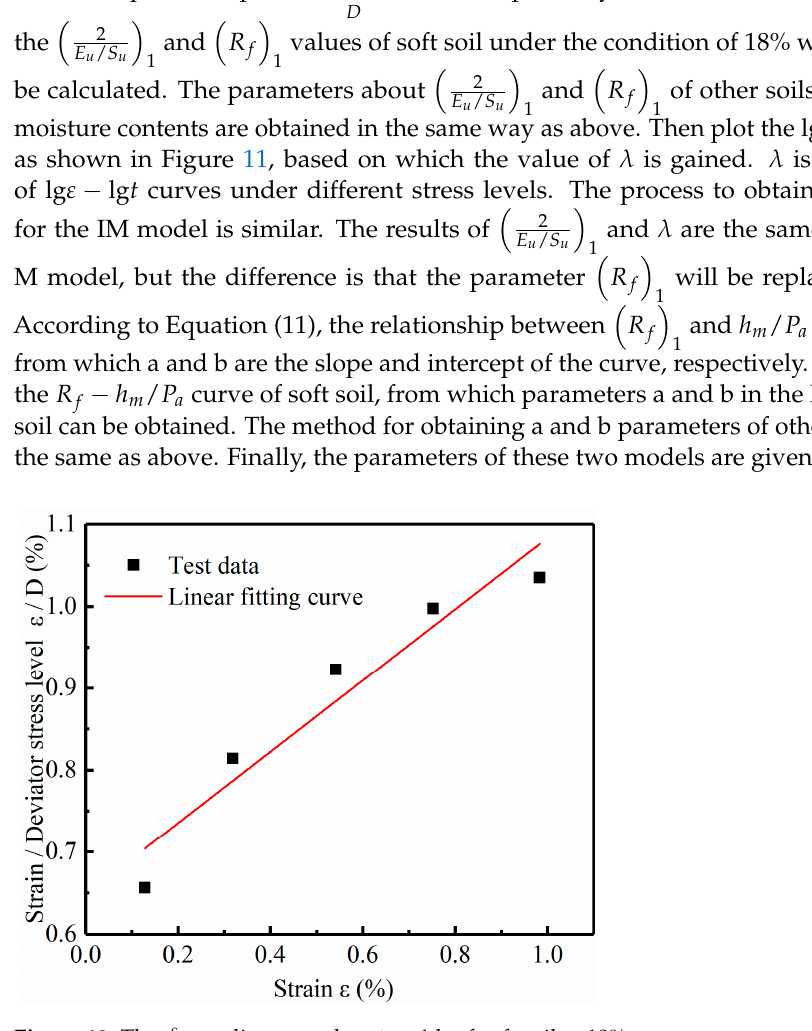
1 = 1 h of soft soil at 18% water